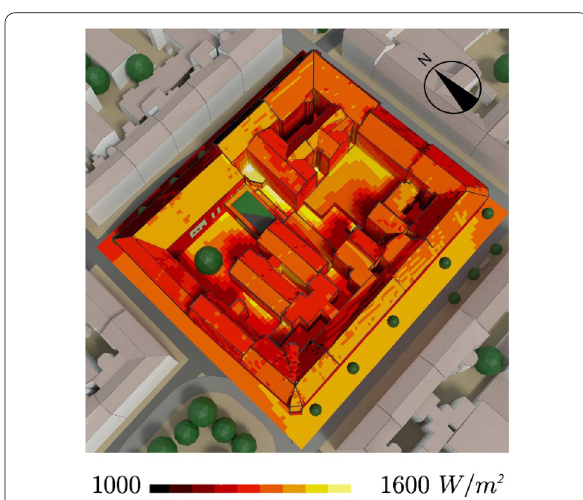
Fig. 20 Incident surface radiation (W/m 2 ) of the simulation case Kandlgasse at 14:00 CEST on 01 August